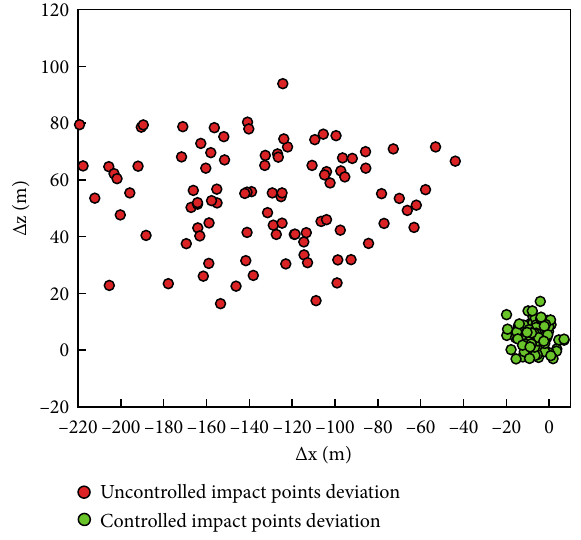
Figure 14: The impact point dispersion cases of the projectile in uncontrolled and controlled